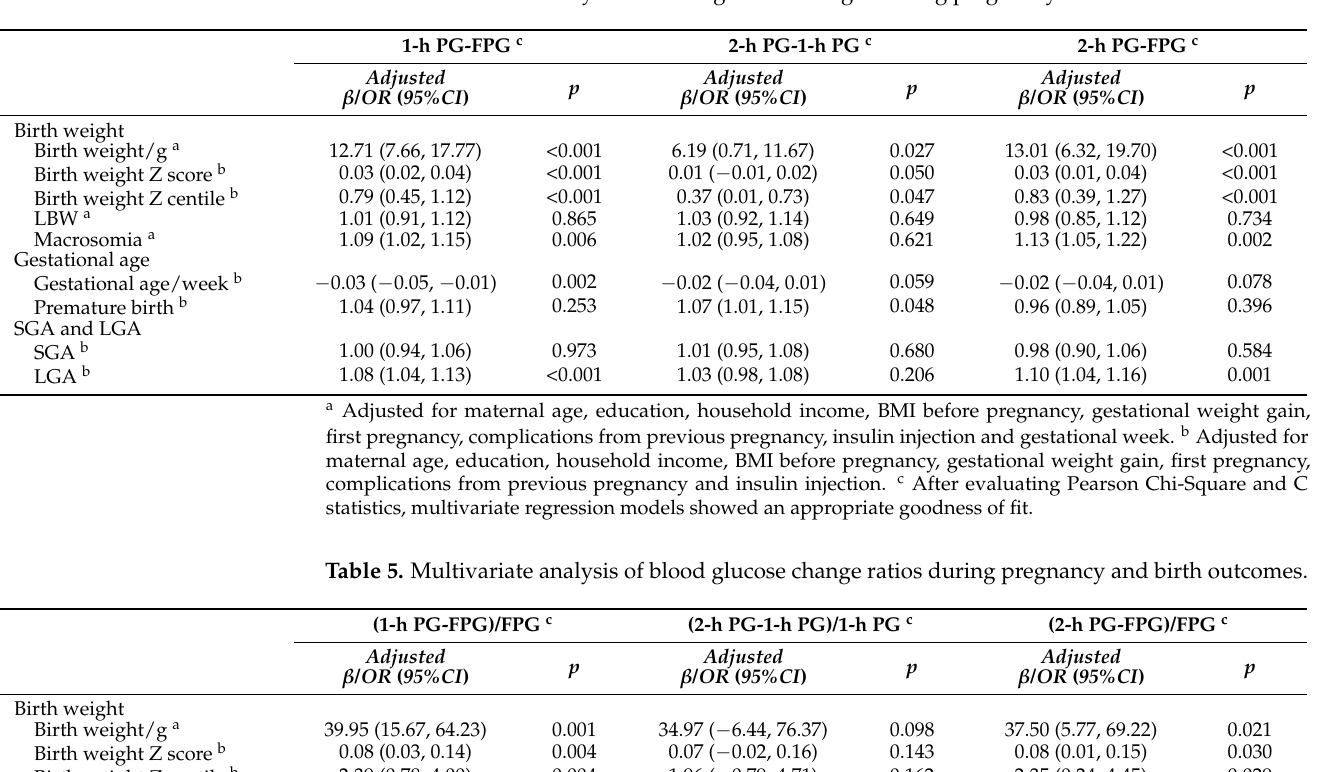
Table 4. Multivariate analysis of blood glucose changes during pregnancy and birth outcomes.